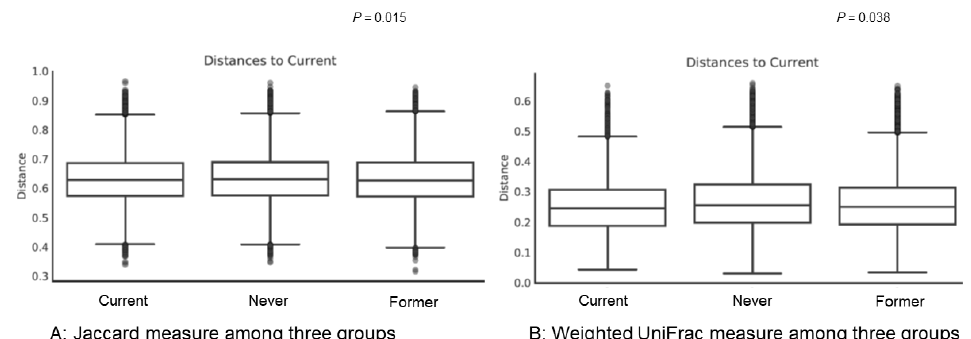
Figure 2. Beta diversity among groups. ( A ) Results of beta diversity using Jaccard measure among current smokers, former smokers, and never smokers; ( B ) results of beta diversity using weighted UniFrac measure among current smokers, former smokers, and never smokers. The y -axes represent the distance of each group to the current group (baseline). The line in each box means the median of data. In both Jaccard measure and Weight UniFrac measure, p -values among three groups were estimated using permutational multivariate analysis of variance (PERMANOVA). PERMANOVA of the diversity analysis was calculated with the 999 Monte Carlo permutation and Benjamini – Hochberg correction (FDR).